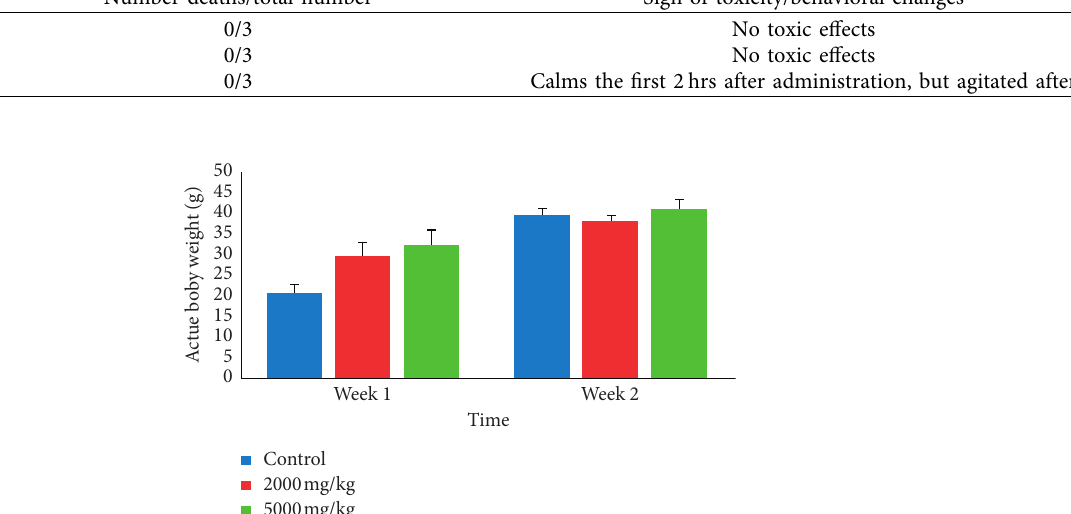
Table 1: Effect of aqueous extract of T. grandis leaves on mortality and behavior of animals during acute administration. Groups